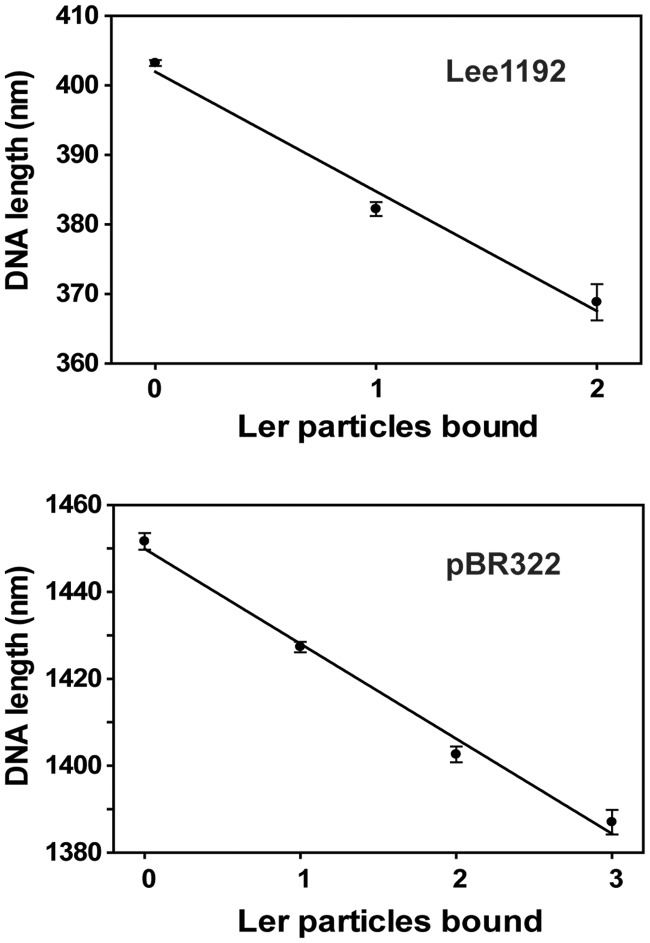
DNA compaction induced by Ler. Plots of DNA contour length (mean ± standard error of the mean) obtained for Lee1192 (top panel) and pBR322 (bottom panel) molecules versus the number of bound Ler particles. The slope of the regression line, 17.2 ± 2.0 nm (Lee1192, R2 = 0.98) and 21.9 ± 1.5 nm (pBR322, R2 = 0.99) represents the average DNA compaction induced by each Ler particle.